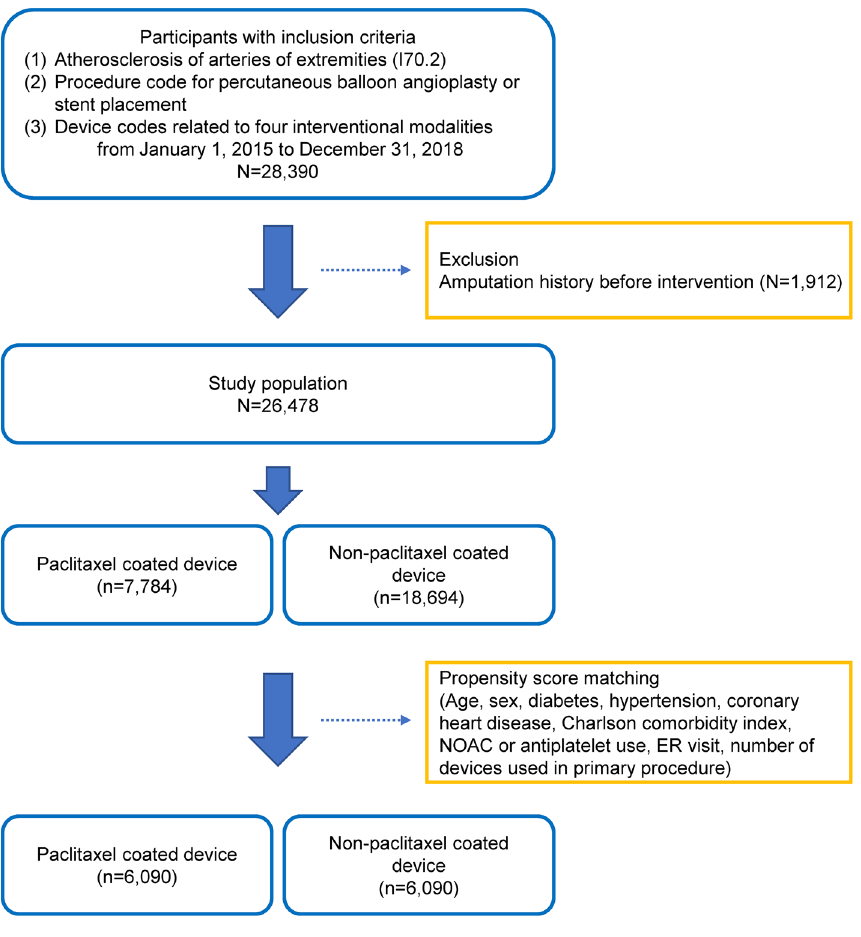
Figure 1. Flow chart of the study design. NOAC: new oral anticoagulants, ER: emergency